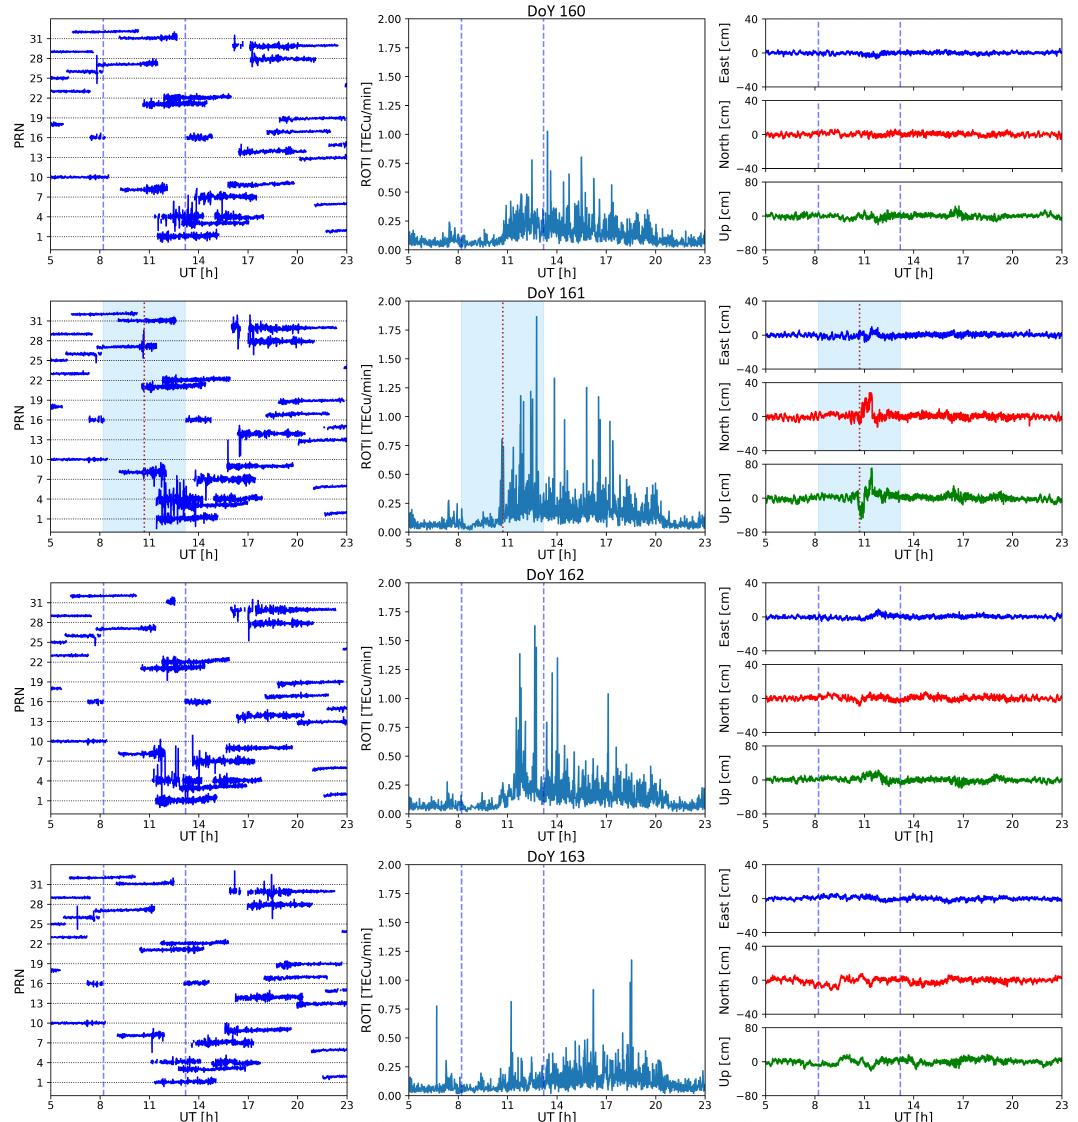
Figure 9. Ionospheric behavior and apparent position variation of the PIFL GNSS station. From top to bottom show DoYs 160–163. ROT (TECu/m) ( left panels ), ROTI (TECu/m) ( middle panels ), DF-GNSS PPP-AR (cm): East [cm] (blue line), North [cm] (red line), and Up [cm] (green line) ( right panels ). P1–P4 time on non-eclipse day (blue dashed lines), P1–P4 time on eclipse day (light blue bar), GE time (red dotted